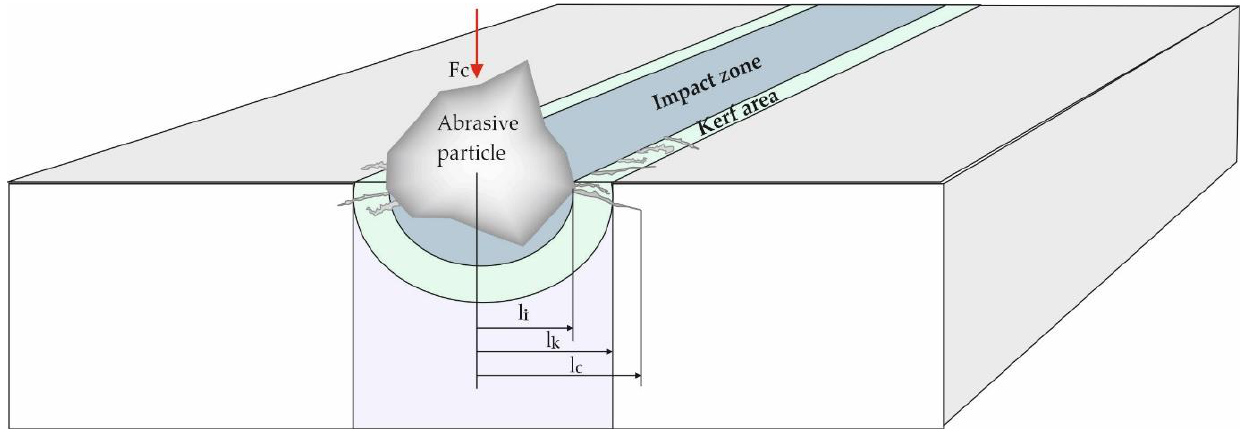
Figure 2. The mechanism of hydro abrasive erosion for brittle materials.